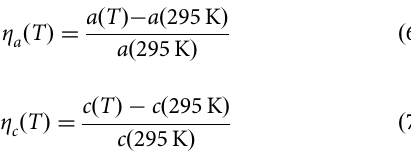
and 4 D with respective slopes θ ZFS 4 D gs ; a gs ; c Fig. 3c, d. For a more in-depth graphical analysis of the complex relationships, please refer to Supplementary Fig. 1.